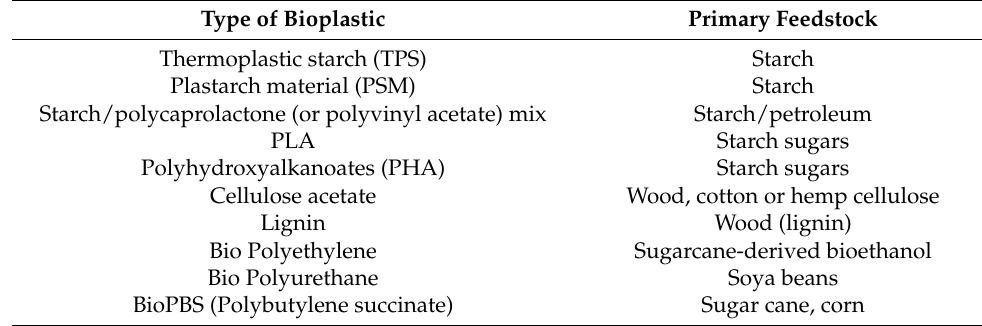
Table 1. Example of